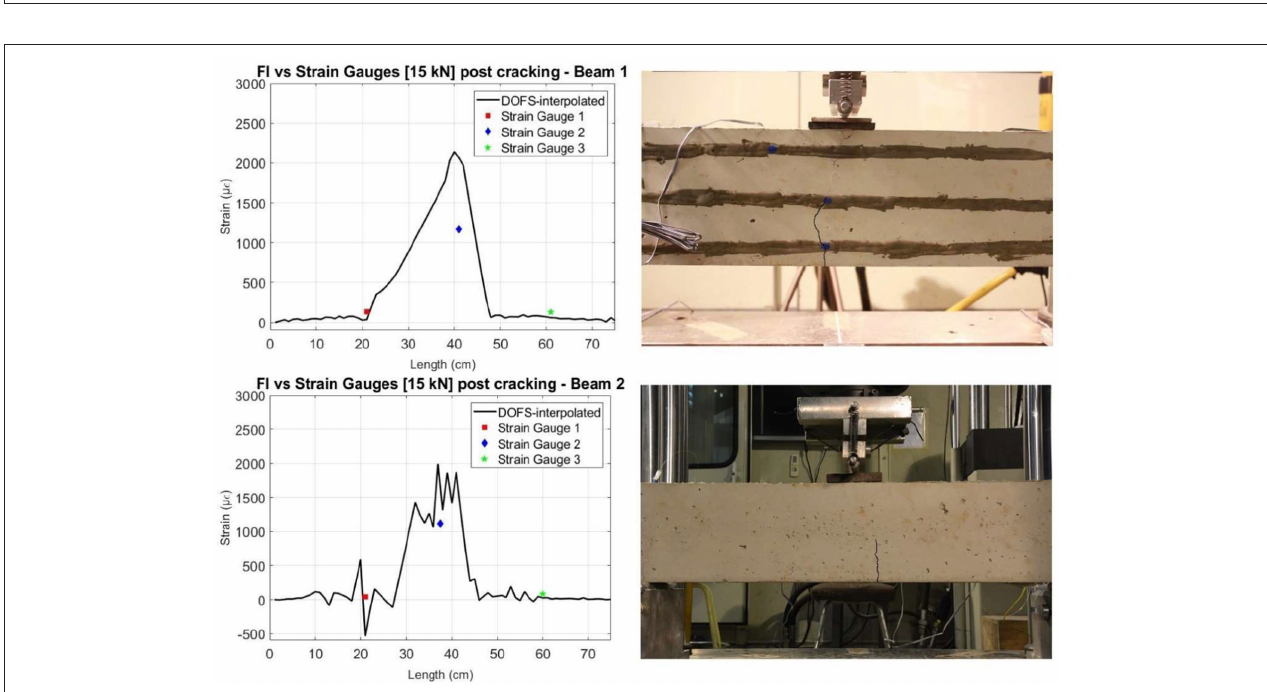
FIGURE 6 | Comparison of interpolated values of DOFS with strain gauges at load level 15 kN (Left) and photo specimen with highlighted crack (Right) – Beam 1 (Top) , Beam 2 (Bottom)